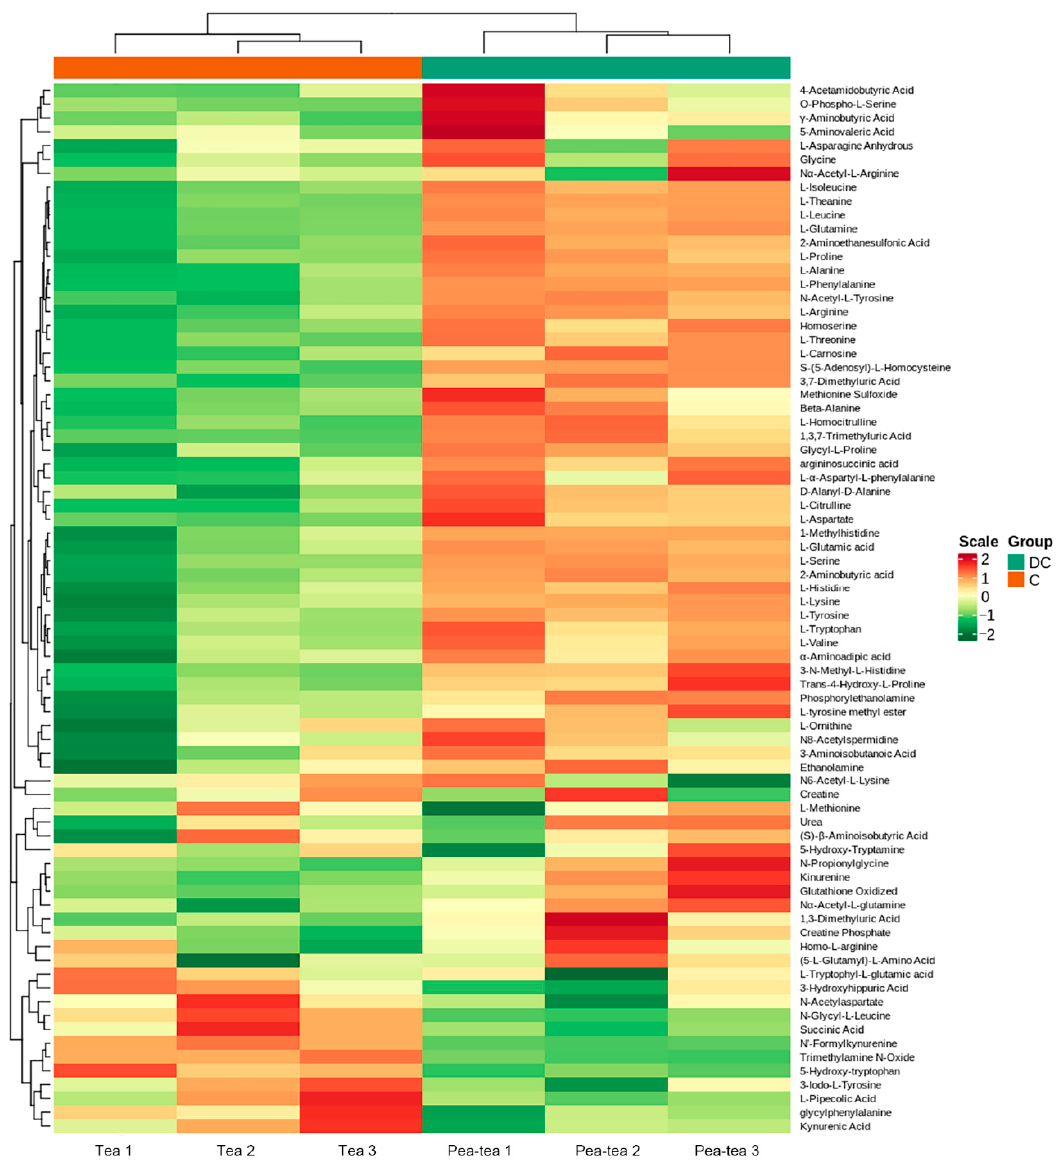
Figure 7. Heatmap of amino acid changes in monocropped and pea intercropped tea